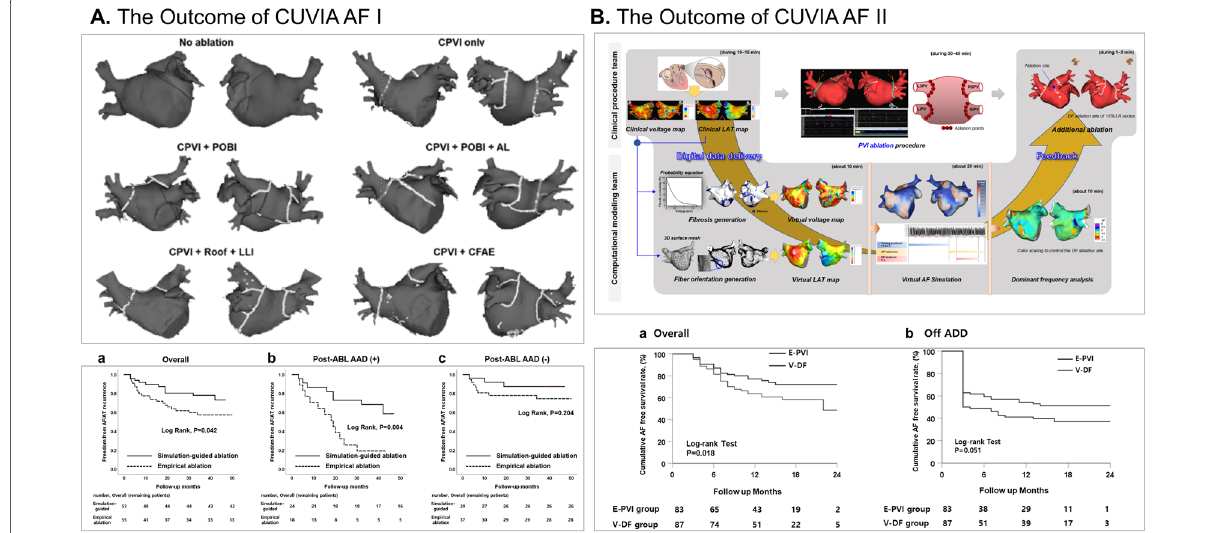
Fig. 6 Clinical trial outcomes of CUVIA‑AF I and CUVIA‑AF II using AF computational modeling. A CUVIA‑AF I compared the effectiveness of the extra‑PV ablation as determined by computational modeling and the operator’s experience. Image was taken from [49]. B CUVIA‑AF II evaluated the effect of additional DF ablation by AF‑DF maps. Both clinical trials were analyzed during the clinical PV isolation